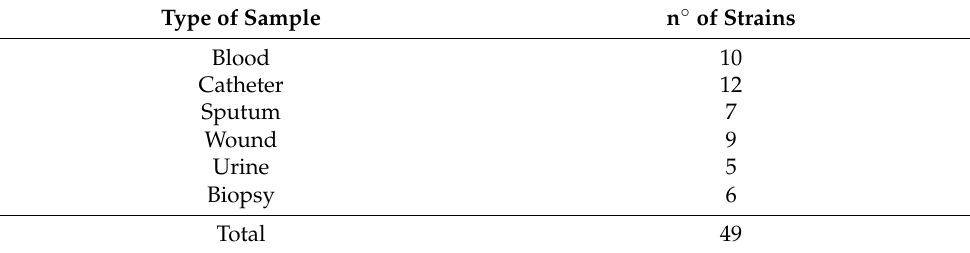
Table 1. Type of